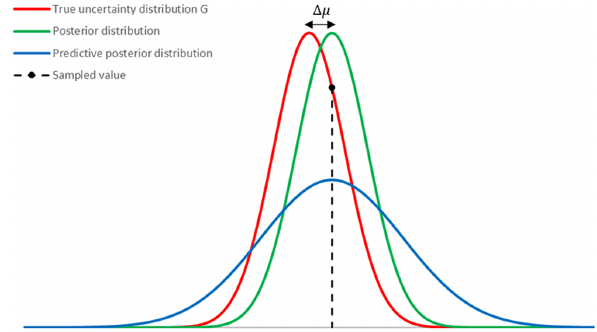
Figure 3. Effect of bias over predictive posterior and posterior dis-